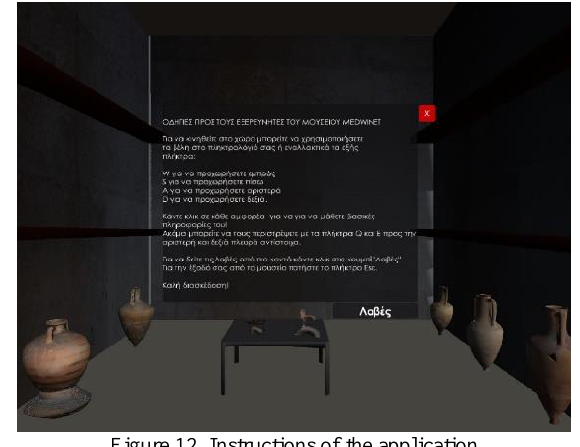
Figure 12. Instructions of the